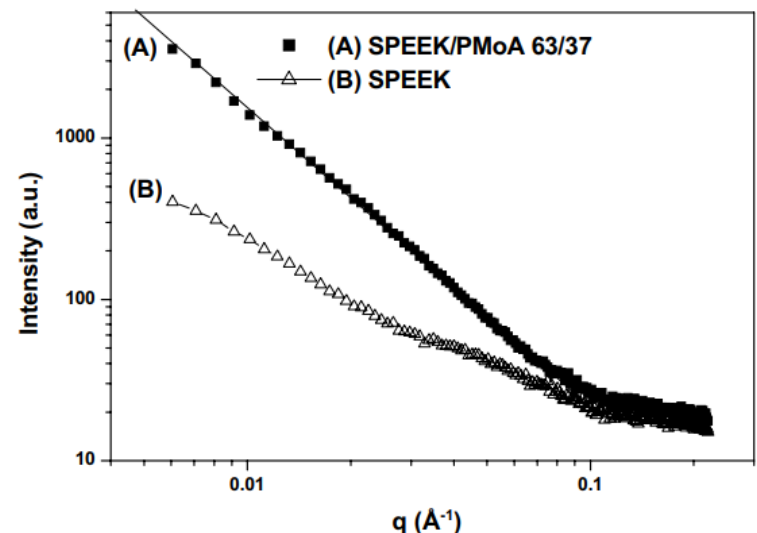
Figure 18. SAXS analysis of sulfonated poly(aryl ether ketone) (SPEEK) / phosphomolybdic acid (PMoA) membranes ( a ), and pristine SPEEK membranes ( b ) [80].